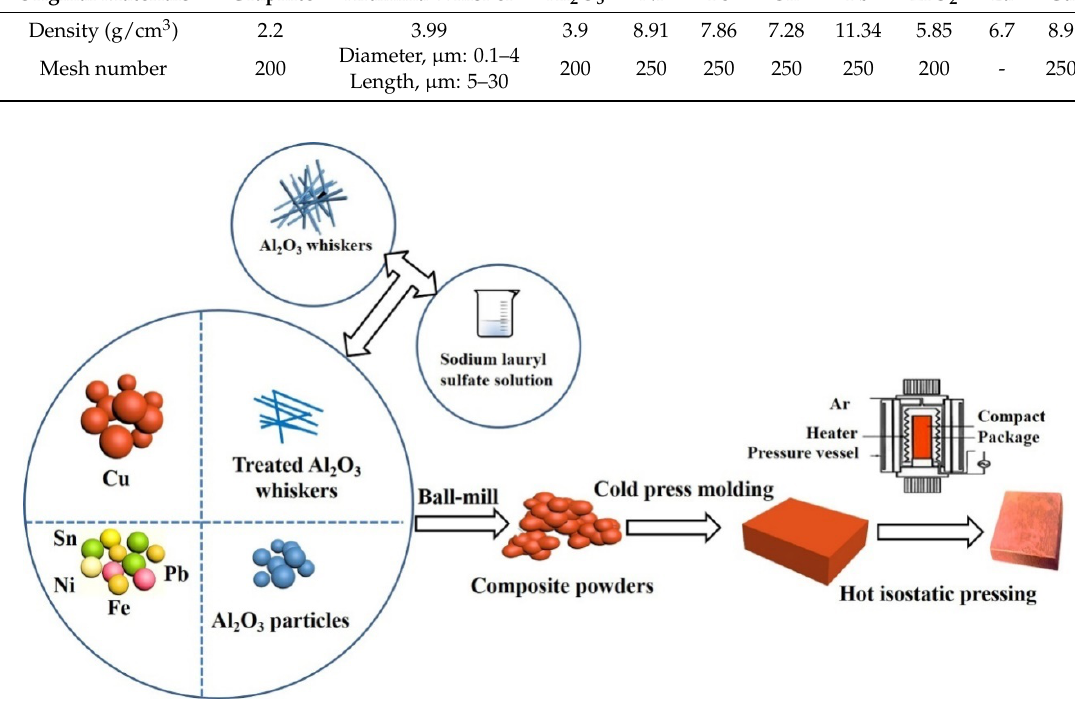
Figure 1. Schematic diagram of the procedures used to fabricate the copper matrix composites.